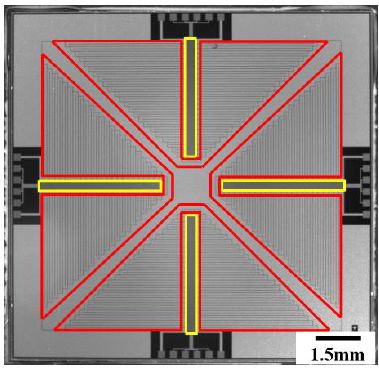
Figure 1. Photograph of the thin-film heaters and resistance temperature detectors (RTDs) on the polymerase chain reaction (PCR) thermal control chip. The areas delineated by the red lines are the thin-film heaters and the areas delineated by the yellow lines are the RTDs.